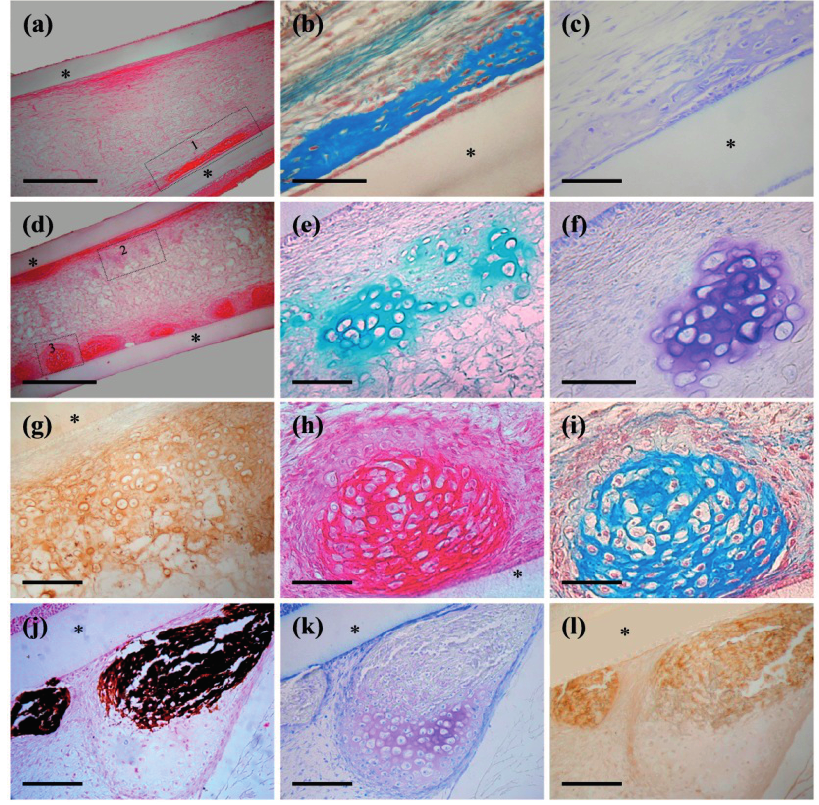
Figure 6. Histological sections of diffusion chambers with 3D culture cells after 4 weeks of in vivo implantation. Different types of tissue can be observed, according to cell type implanted. Asterisks (*) represent filters of the chambers. ( a – c ) rhTGF- β 1-F2-treated cultures induced with a pulse of rhBMP-2. In vivo bone-like tissue formation was demonstrated. ( a ) PSH (picrosirius-hematoxyline); ( b – c , details from zone 1) Goldner’s trichrome and TB (toluidine blue) stain; ( d – l ) rhTGF- β 1-F2 and rhBMP-2-treated culture cells. Several nodules of cartilage and bone-like tissue located near the filters were observed. ( d ) PSH; ( e – g , details from zone 2) AB (alcian blue), TB and type II collagen immunohistochemistry; ( h – i , details from zone 3) PSH and Goldner’s trichrome stain; ( j ) von Kossa stain; ( k ) TB; ( l ) type I collagen immunohistochemistry. Bars, 500 μ m